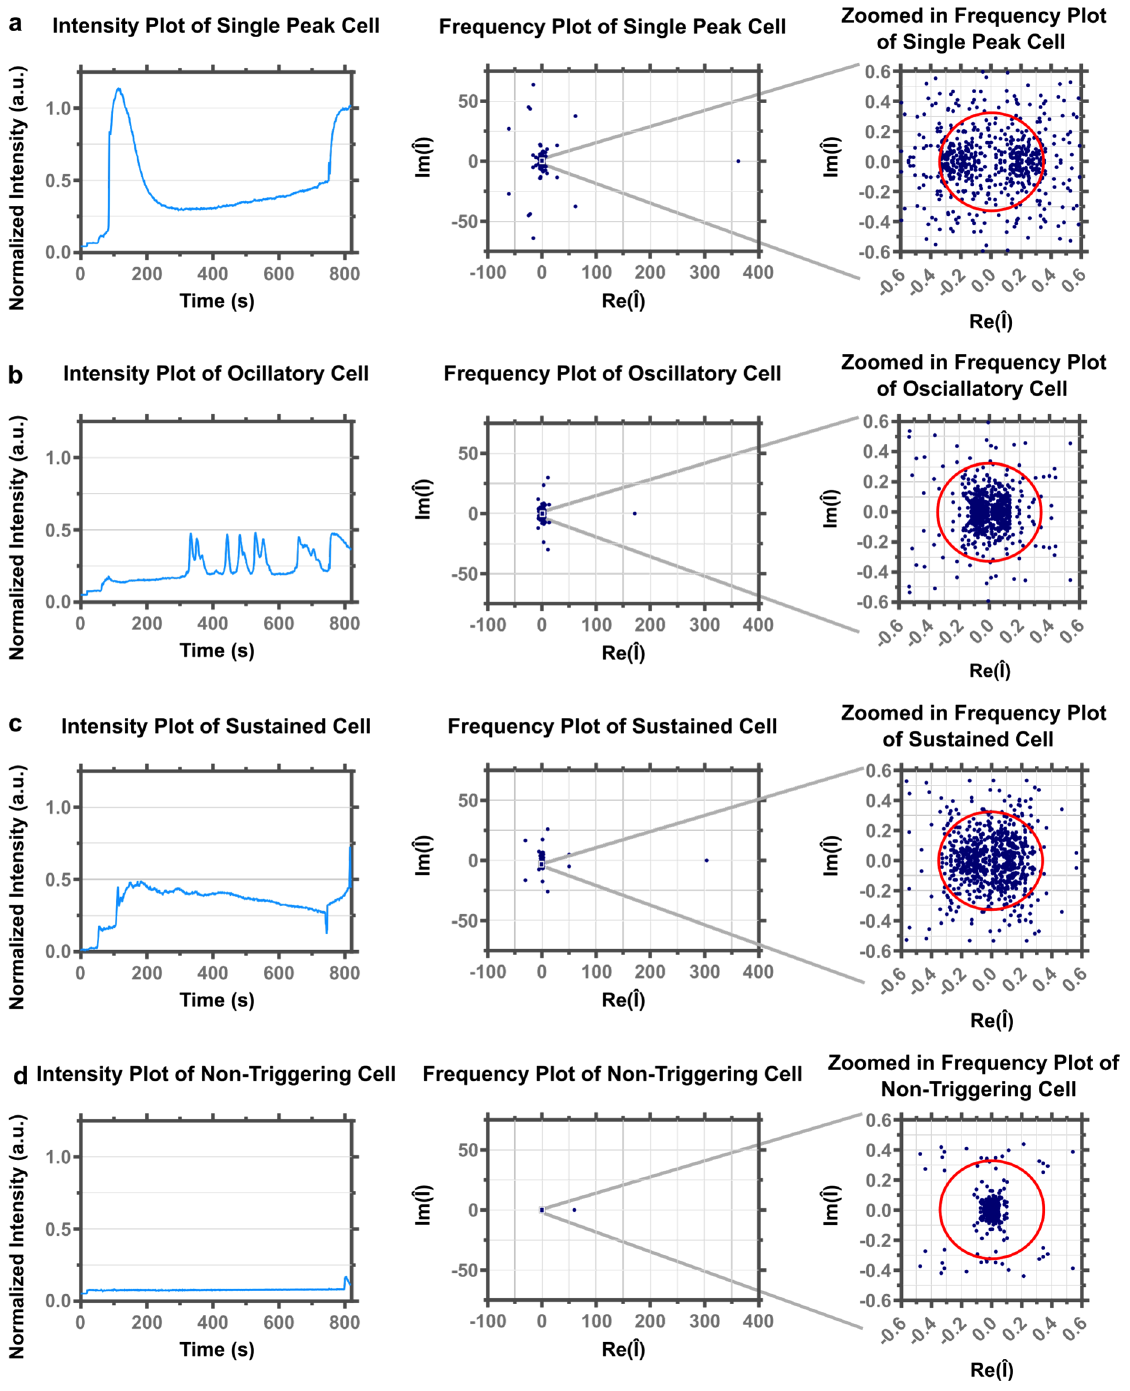
Figure 3. Example plots of normalized Ca 2 + intensities over time (left) and calcium responses Fourier transformed (middle and right) in individual 1G4-TCR T cells that came into contact with a 9V:MHC functionalized coverslips. The right plots are zoomed in versions of the middle plots. ( a ) A T cell with a single Ca 2 + intensity peak. ( b ) A T cell with multiple Ca 2 + intensity peaks (oscillatory). ( c ) A T cell with a sustained Ca 2 + intensity maximum. ( d ) A T cell without a Ca 2 + intensity maximum that surpasses 0.2 a.u. The triggering radius of 0.34 is shown as the red